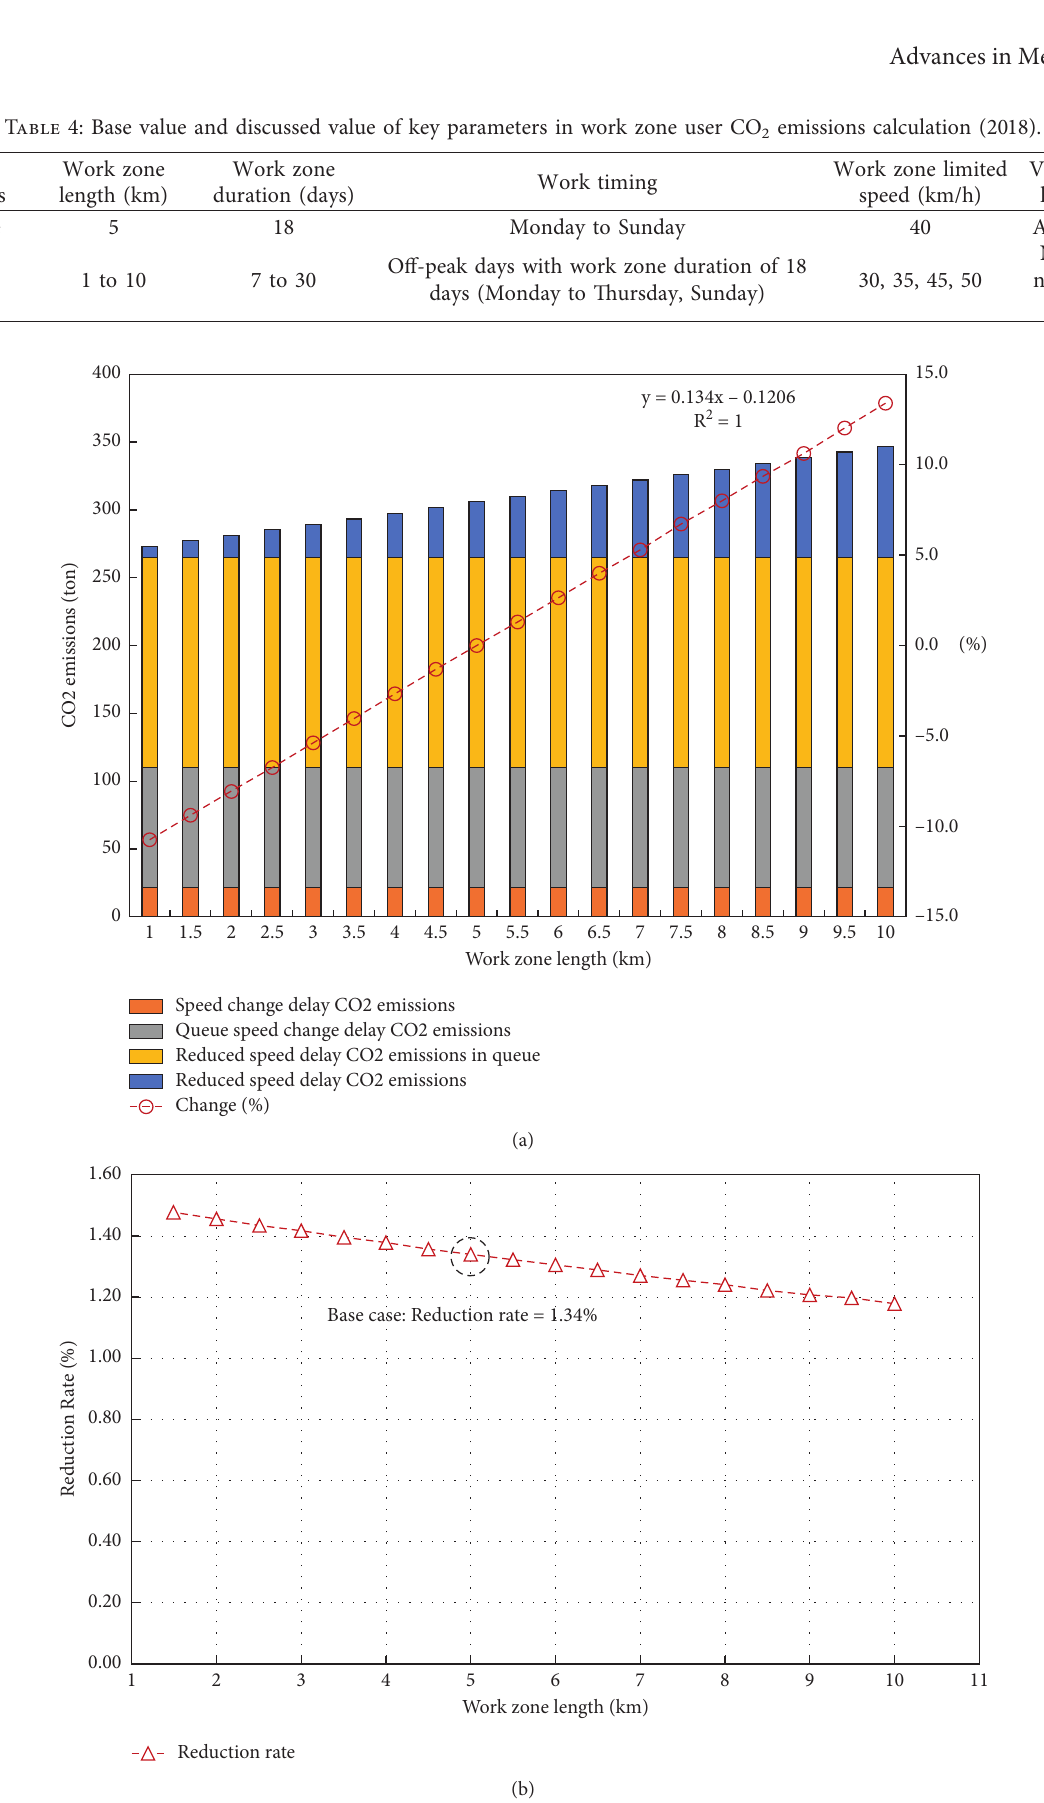
Figure 5: (a) Total work zone user CO 2 emissions and change rate compared to base case for different work zone length; (b) reduction rate of total work zone user CO 2 emissions per 500-meter reduction for different initial work zone